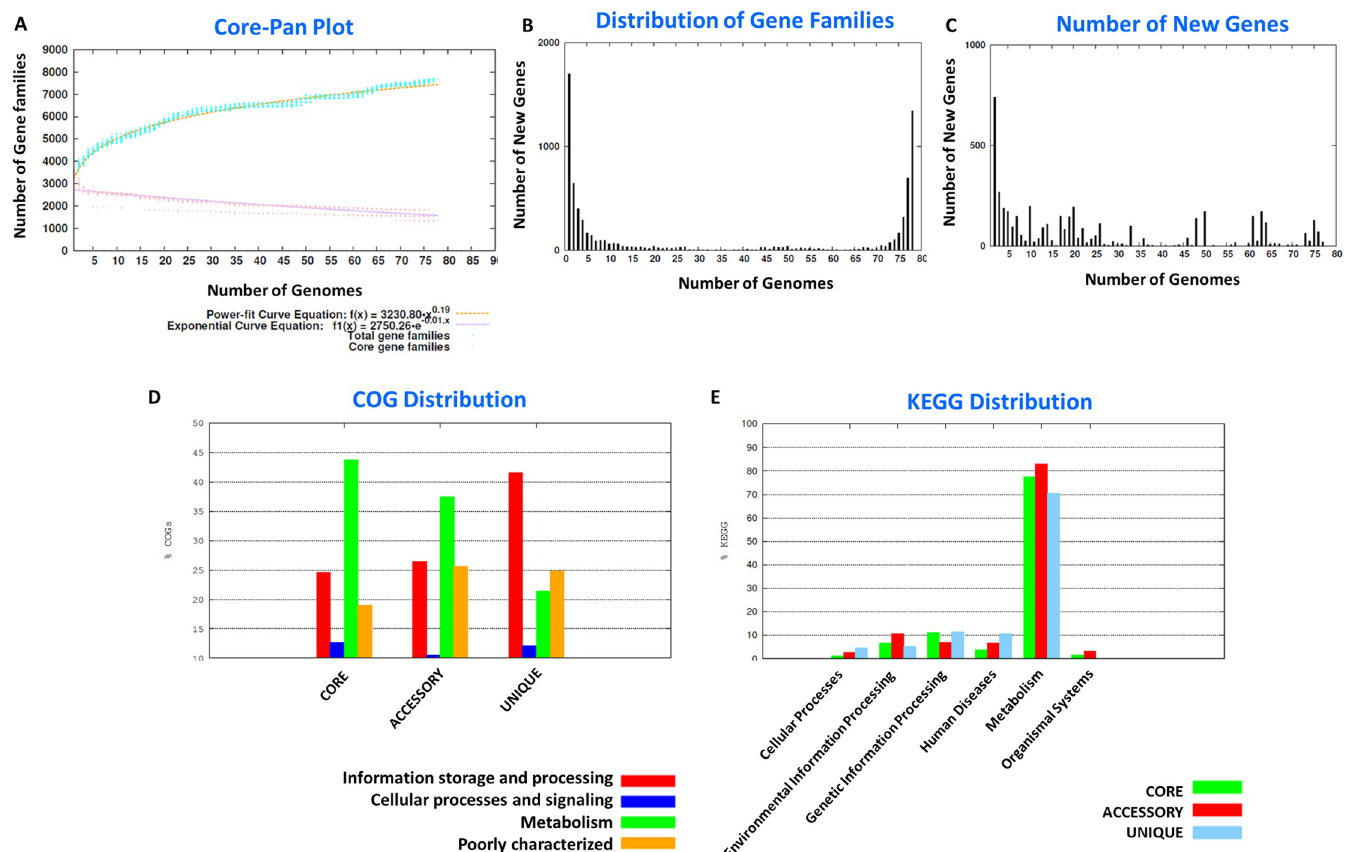
Fig 3. Pan genome analysis. Panel A indicates the pan and core genome curves. Panel B shows the frequency distribution of gene families within genomes. The number of new genes added to each genome is depicted in panel C. The COG and KEGG distribution of the representative proteins in the core, accessory, and unique genome are shown in panels D, and E